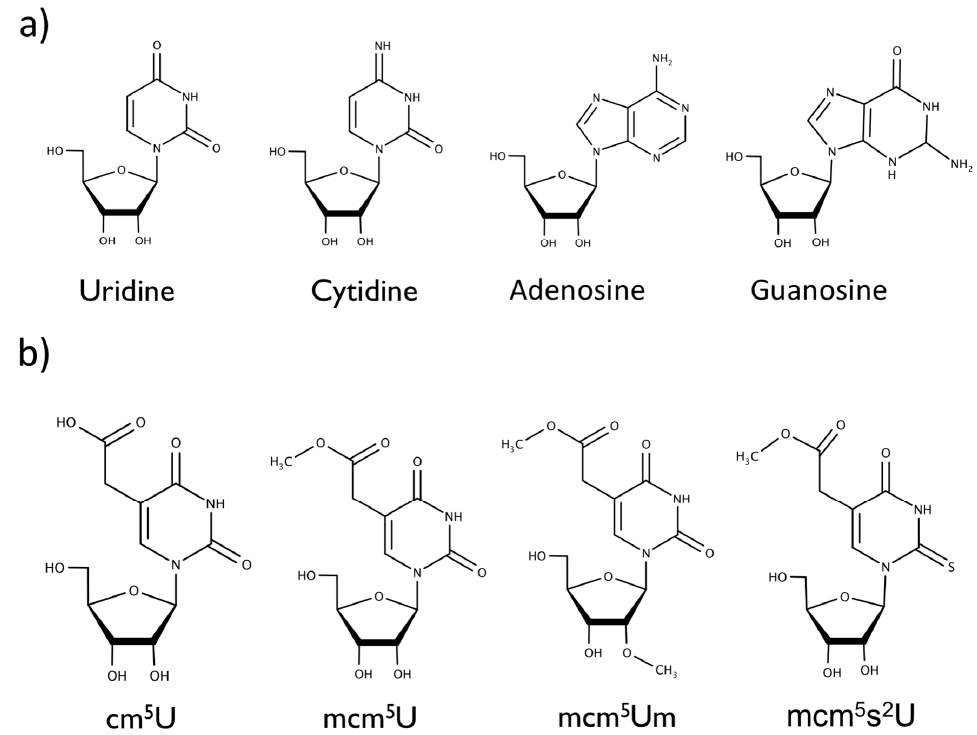
Figure 1. Chemical structures of the ( a ) canonical nucleosides uridine, cytidine, adenosine, guanosine, and ( b ) modifications to wobble uridine 34 in the anticodon stem loop, 5-carbonyl-methyluridine (cm 5 U), 5-methoxycarbonyl-methyluridine (mcm 5 U), 5-methoxycarbonyl-2 (cid:48) - O -methyluridine (mcm 5 Um), and 5-methylcarboxymethyl-2-thiouridine (mcm 5 s 2